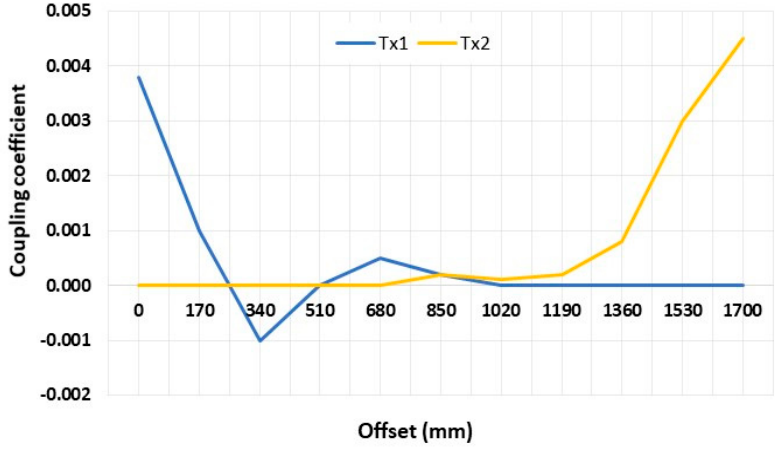
Figure20. Variationofthecouplingcoe ffi cient(k)foreverystepoftheO ff Figure 20. Variation of the coupling coefficient (k) for every step of the Offset in the CP–DD configuration.